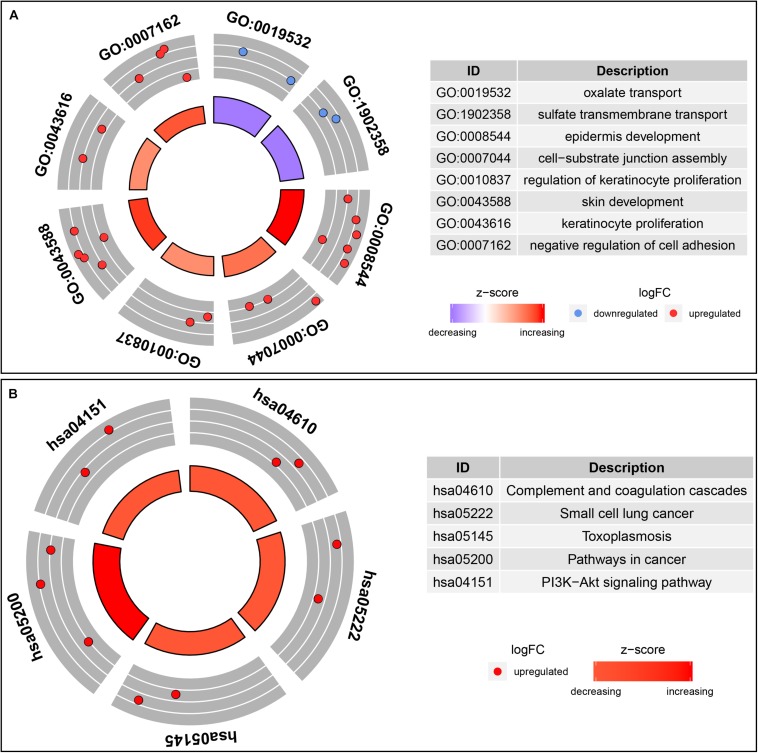
Functional enrichment analysis of methylation-driven genes in thyroid cancer. (A) GO enrichment analysis. (B) KEGG enrichment analysis. The color of inner circle represents z score while the band thickness of inner circle represents the significance of GO terms (log10-adjusted p values). The outer circle represents the expression (log2 FC) of methylation-driven mRNAs in each enriched GO (gene ontology) term: red dots indicate upregulated methylation-driven mRNAs while blue dots indicate downregulated methylation-driven mRNAs.